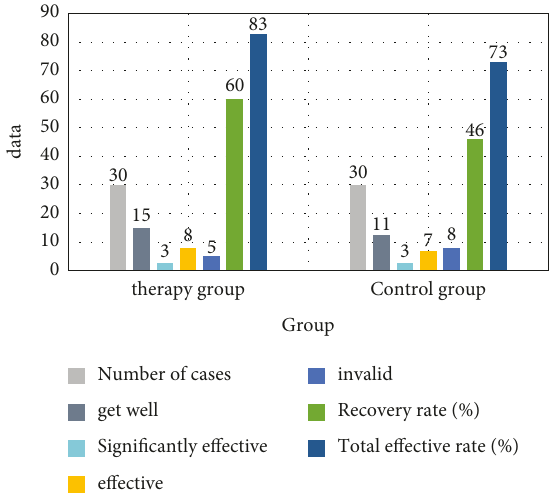
Figure 4: Comparison of two groups after treatment efficiency.